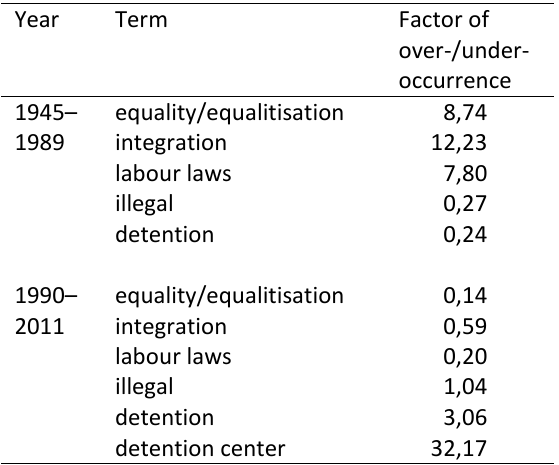
Table 2. Re-embedding of asylum issues. The table lists the relative frequency of indicator terms in contributions dealing with asylum as compared to other